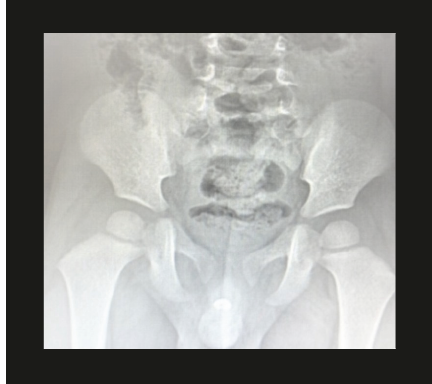
Figure 2: Plain abdominal radiograph showing the urethral calculus (case 1).